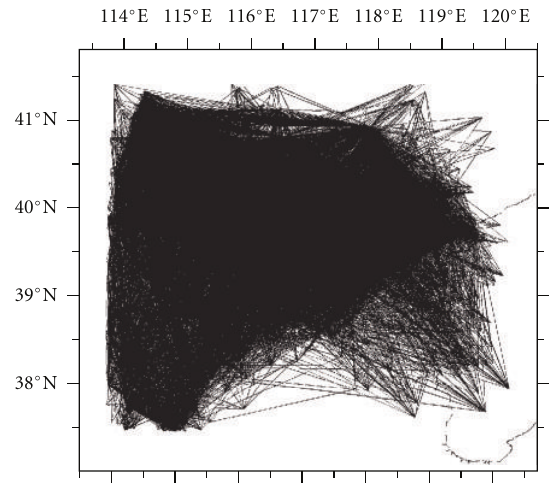
Figure 3: Distribution of P wave ray paths used in this study in map